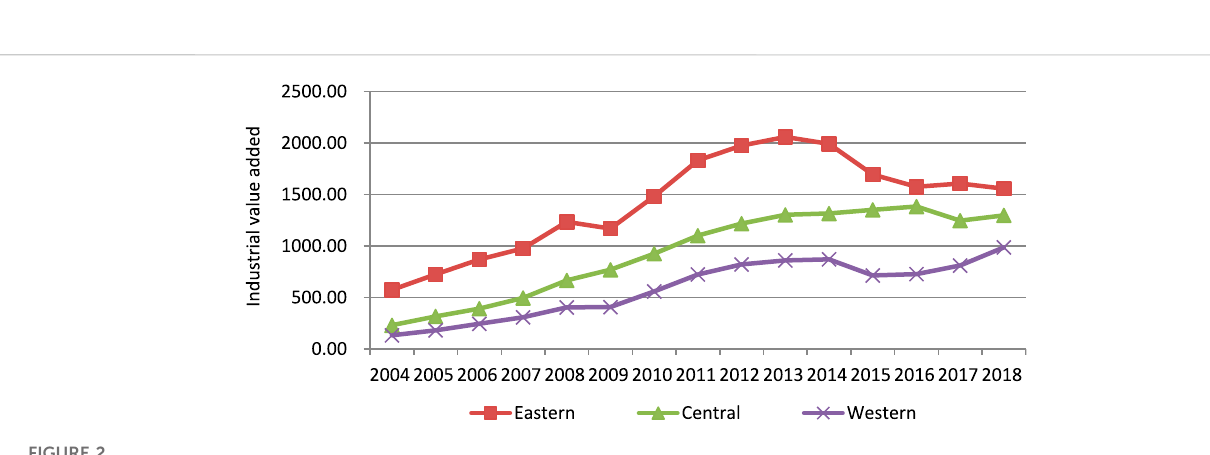
Frontiers in Earth